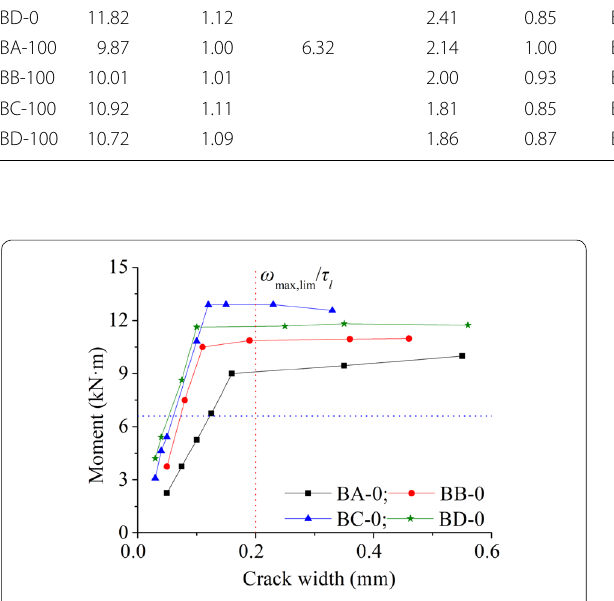
Fig. 6 Maximum crack widths under testing load.